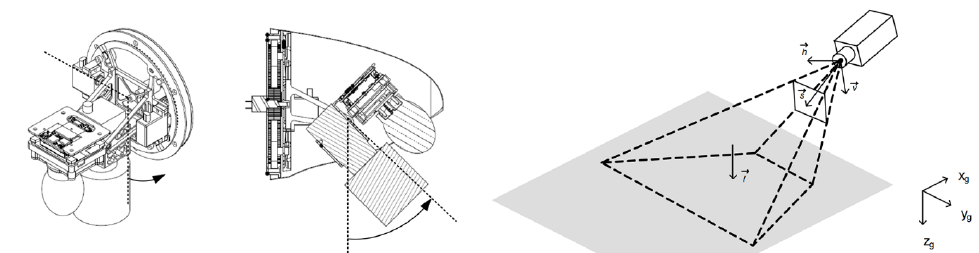
Figure 1. ( Left ) Technical drawing of the available gimbals in perspective and side views. Shown is the suspension of the sensors and the movable axes. ( Right ) The view frustum generated by the camera gimbals and the view